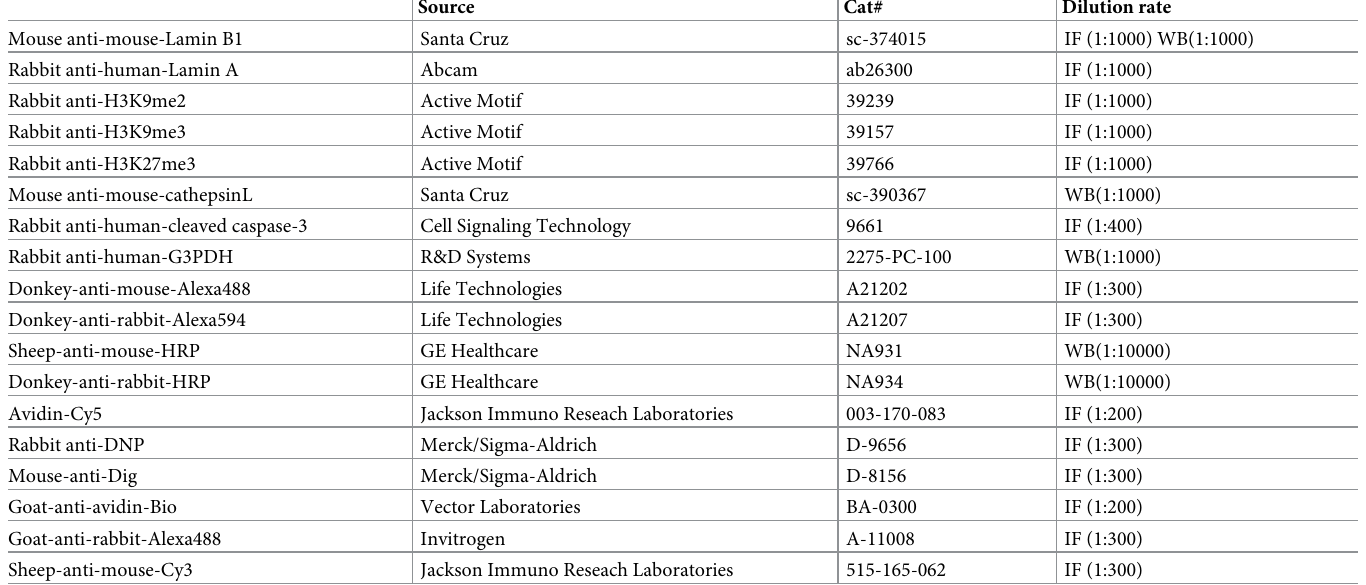
Table 2. Antibodies used for western blotting and